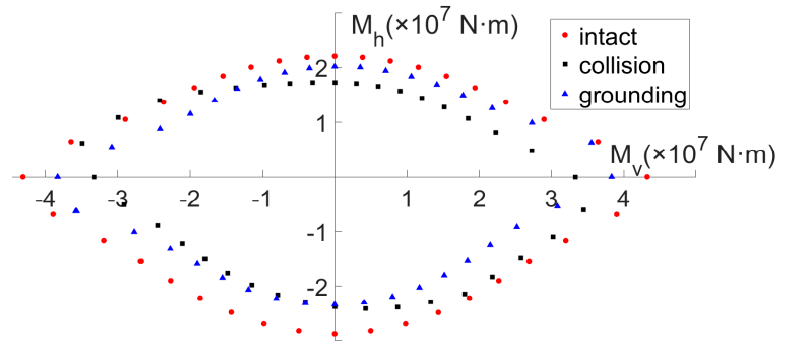
Figure 17. Distribution of sample points of VLCC in different cases.